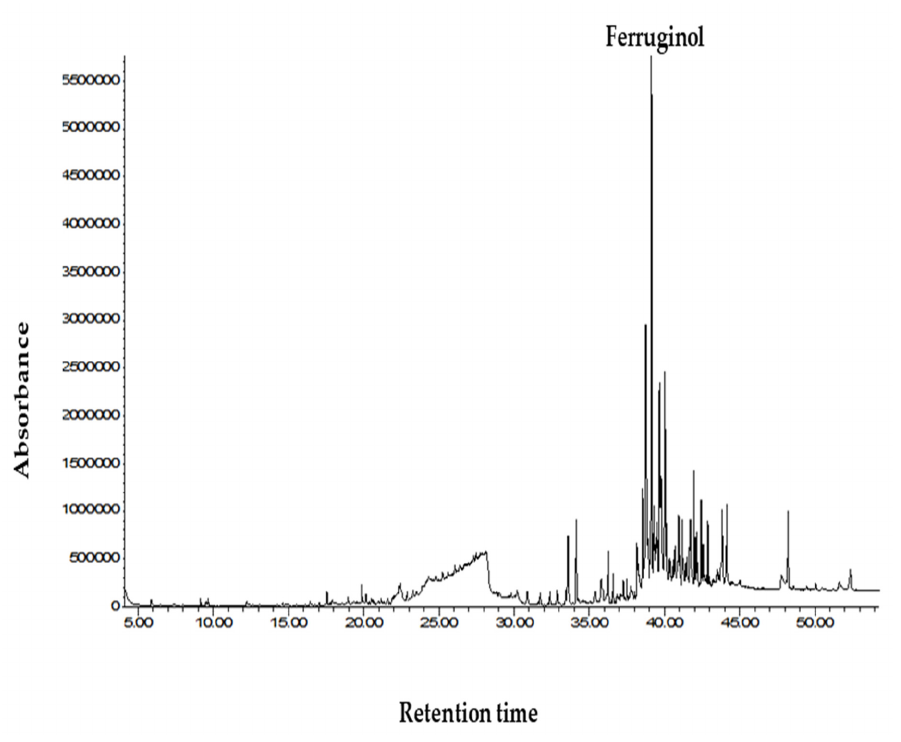
Figure 5. GC chromatogram of the ethanol seed extract of Juniperus procera.